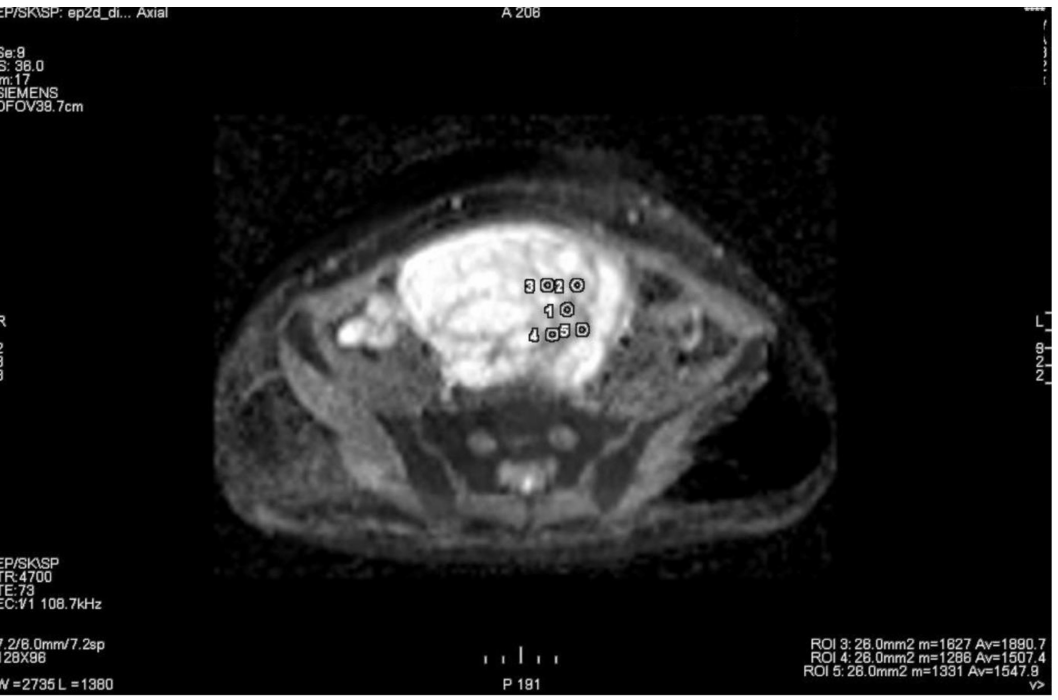
Figure 5. The same 24-year-old patient with MOC Diffusion-ADC maps. Multiple small ROI are placed on a region which is the most solid part of the